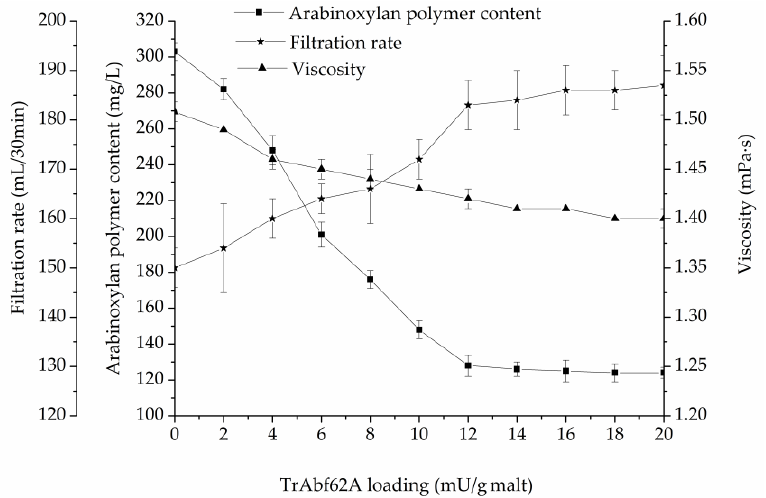
Figure 5. Effects of supplemented TrAbf62A on the arabinoxylan polymer content, viscosity, and filtration rate of wort.